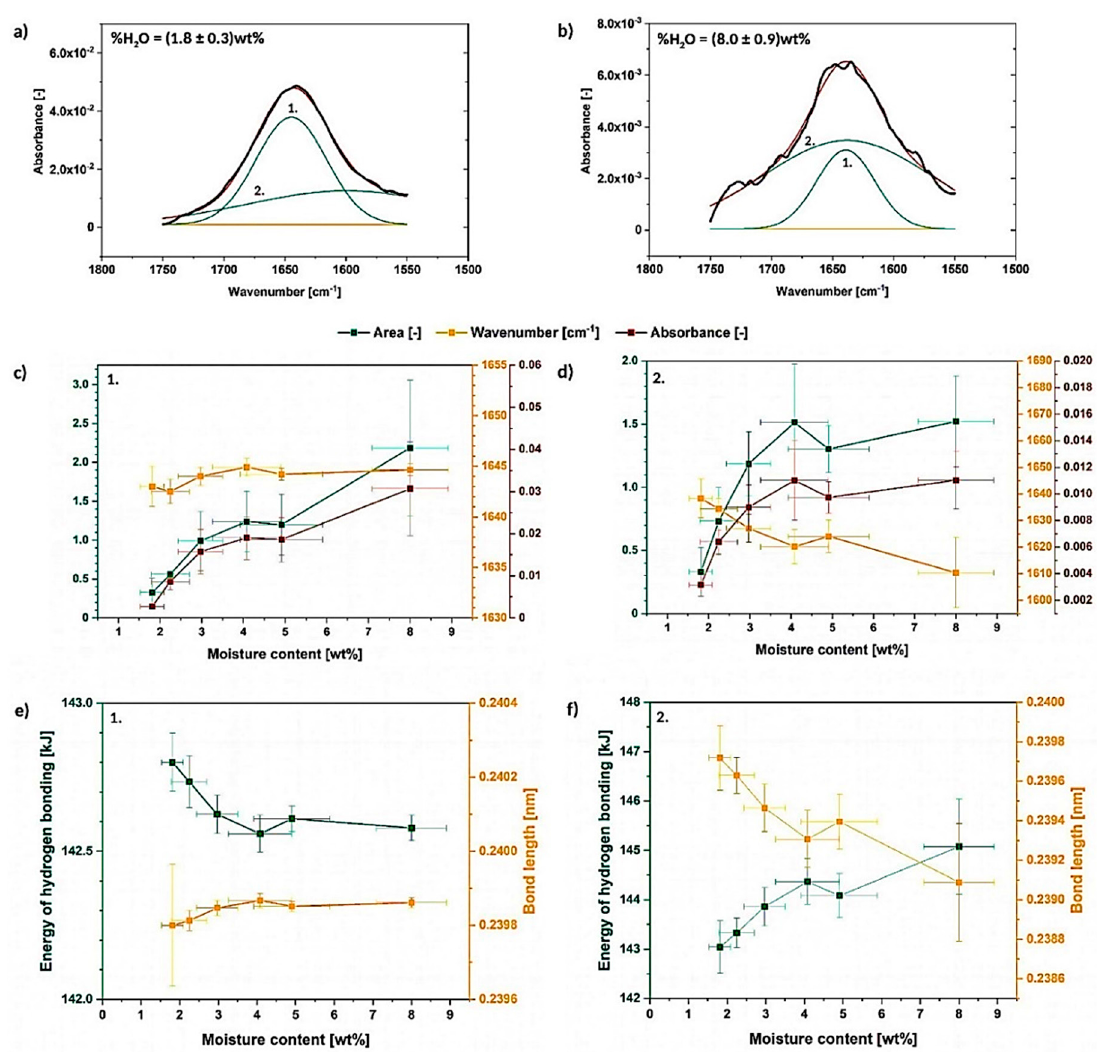
Figure 5. Deconvoluted absorption band between 1750–1550 cm − 1 for the cellulose moisture content of (1.8 ± 0.3) wt% ( a ) and (8.0 ± 0.9) wt% ( b ) with graphs illustrating the changes in the deconvoluted peak area, wavenumber and absorbance ( c , d ), as well as energy and length of hydrogen bonds assigned to the resolved signals ( e , f ).